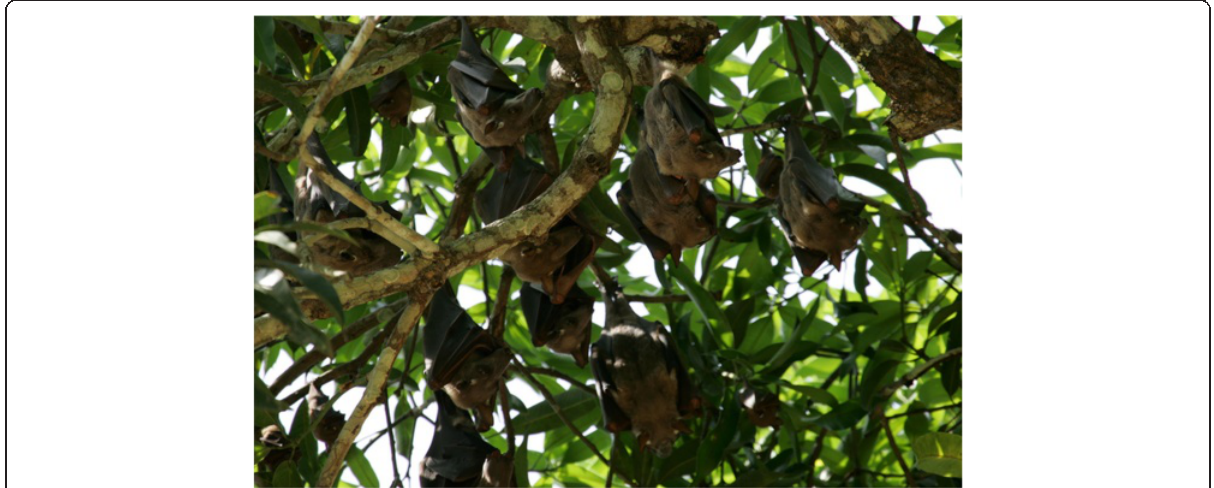
Figure 4 Group of bats Hypsignathus monstrosus in a mango tree in Lambaréné, Gabon (photo by Jean-Jacques Lemasson,